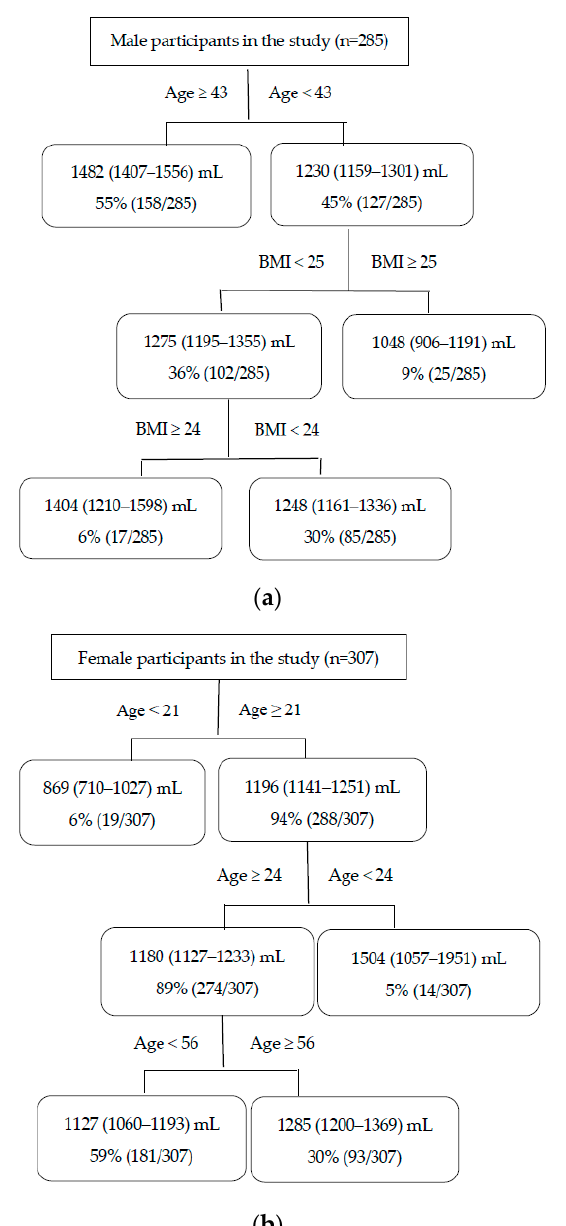
Figure 3. Impacts of age and BMI on daily water consumption among the adults in winter according to CART analysis in the study (age: years, BMI: kg/m 2 ). The figures in the rectangle indicate the mean (95% CI) values of daily water consumption and the probability; a: male, b: female.